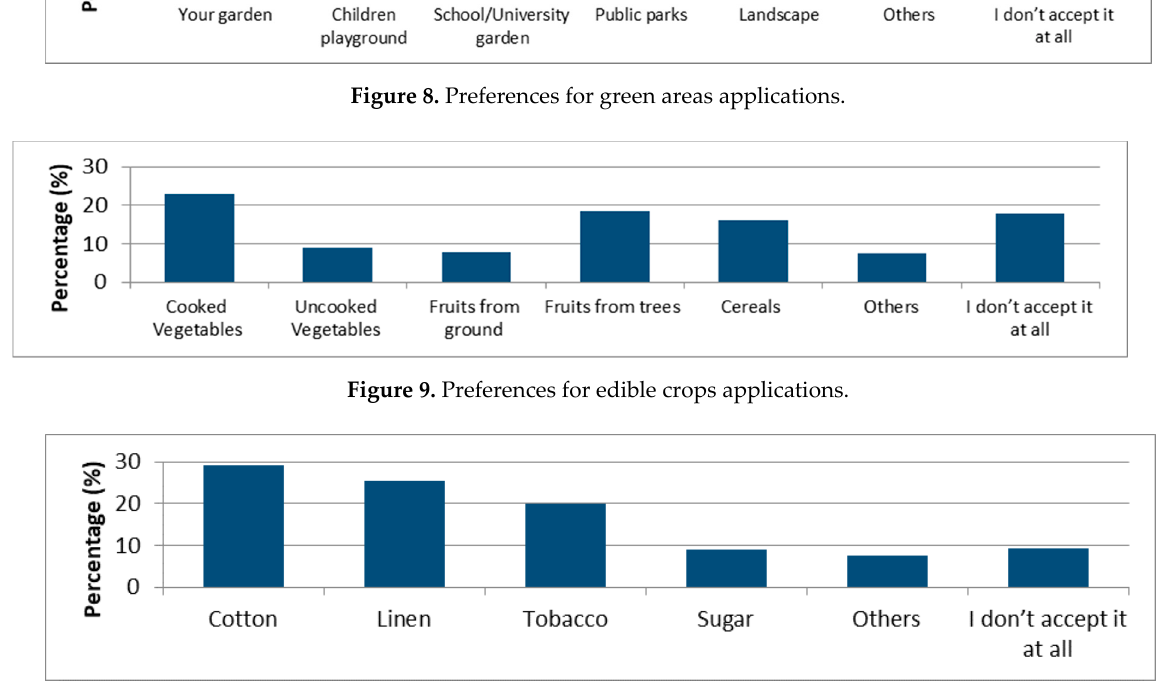
Figure 10. Preferences for industrial